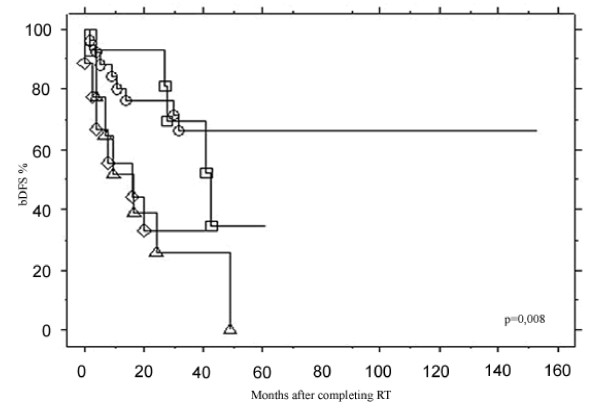
Comparisons of bDFS after the end of RT according to different preRT PSA thresholds. PSA < 0.5 ng/ml(○) vs. [0.5–1] ng/ml(□) vs. [1–2] ng/ml(Δ) vs. ≥2 ng/ml(◇).